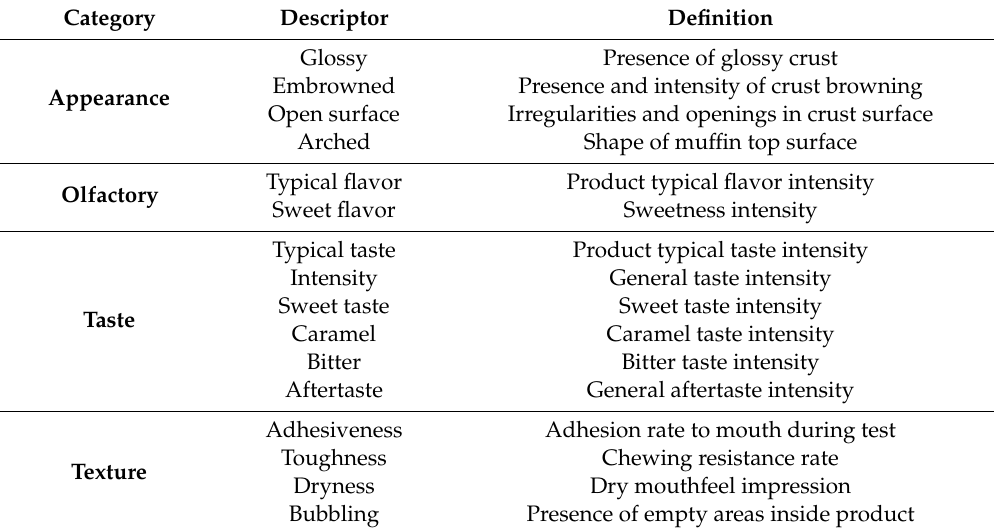
Table 1. Mu ffi n sensory descriptor